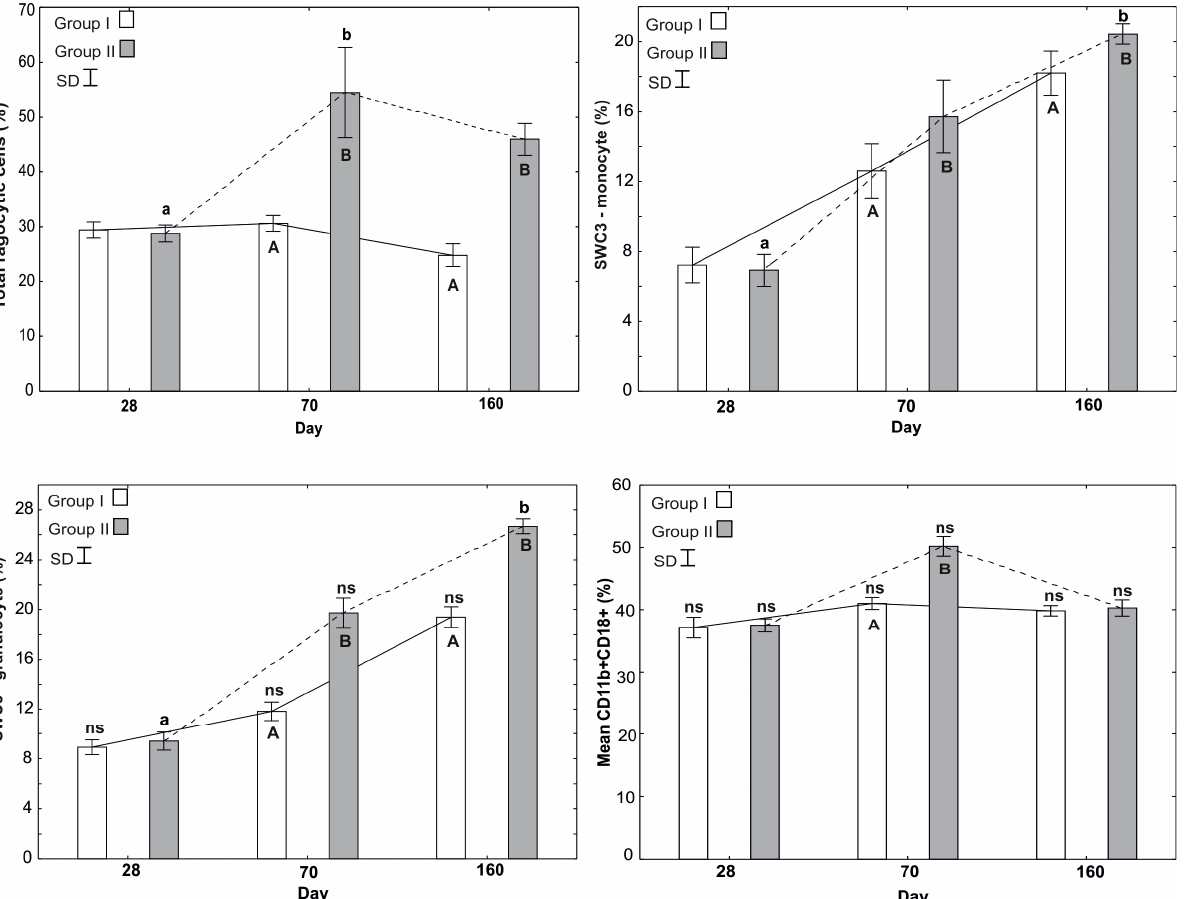
Figure 1. Percentages of total phagocytic cells, SWC3 on monocytes, SWC3 on granulocytes, and CD11 + CD18 + in the peripheral blood of pigs. Values are expressed as mean and standard deviation ( α ± SD). One-way ANOVA followed by Friedman’s and Mann–Whitney U test was used to show the significance of statistical differences ( p ≤ 0.05) between the control and experimental groups. Capital le tt ers indicate statistically signi fi cant results between groups (U test), and lower-case le tt ers indicate signi fi cant di ff erences in the Friedman test and post hoc tests. I—control group, and II— experimental group.